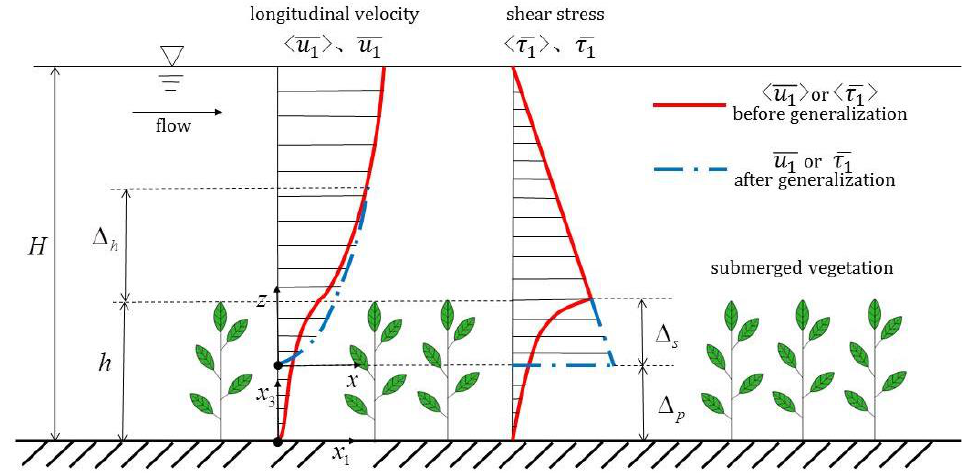
Figure 1. Generalization of flow longitudinal velocity and shear stress.